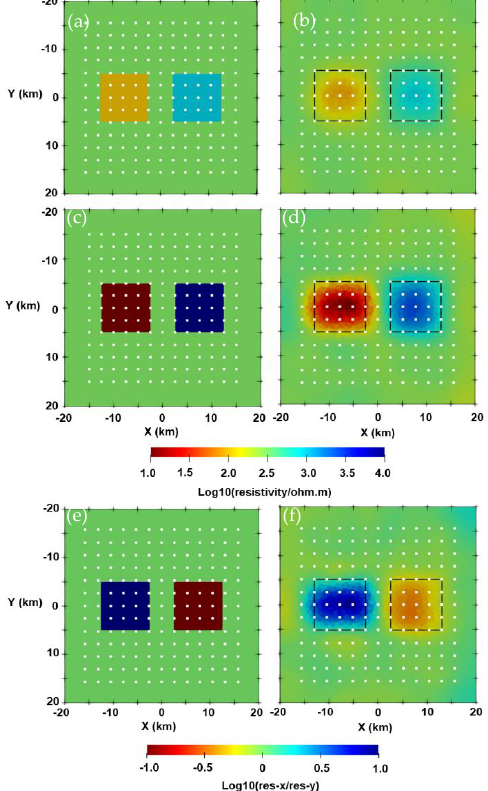
Figure 12. Anisotropic inversion results at z = 6 km. Panels ( a ), ( c ), and ( e ) show the true model for the principal X and Y directions, and the anisotropic coefficient. Panels ( b ), ( d ), and ( f ) show the corresponding inversion